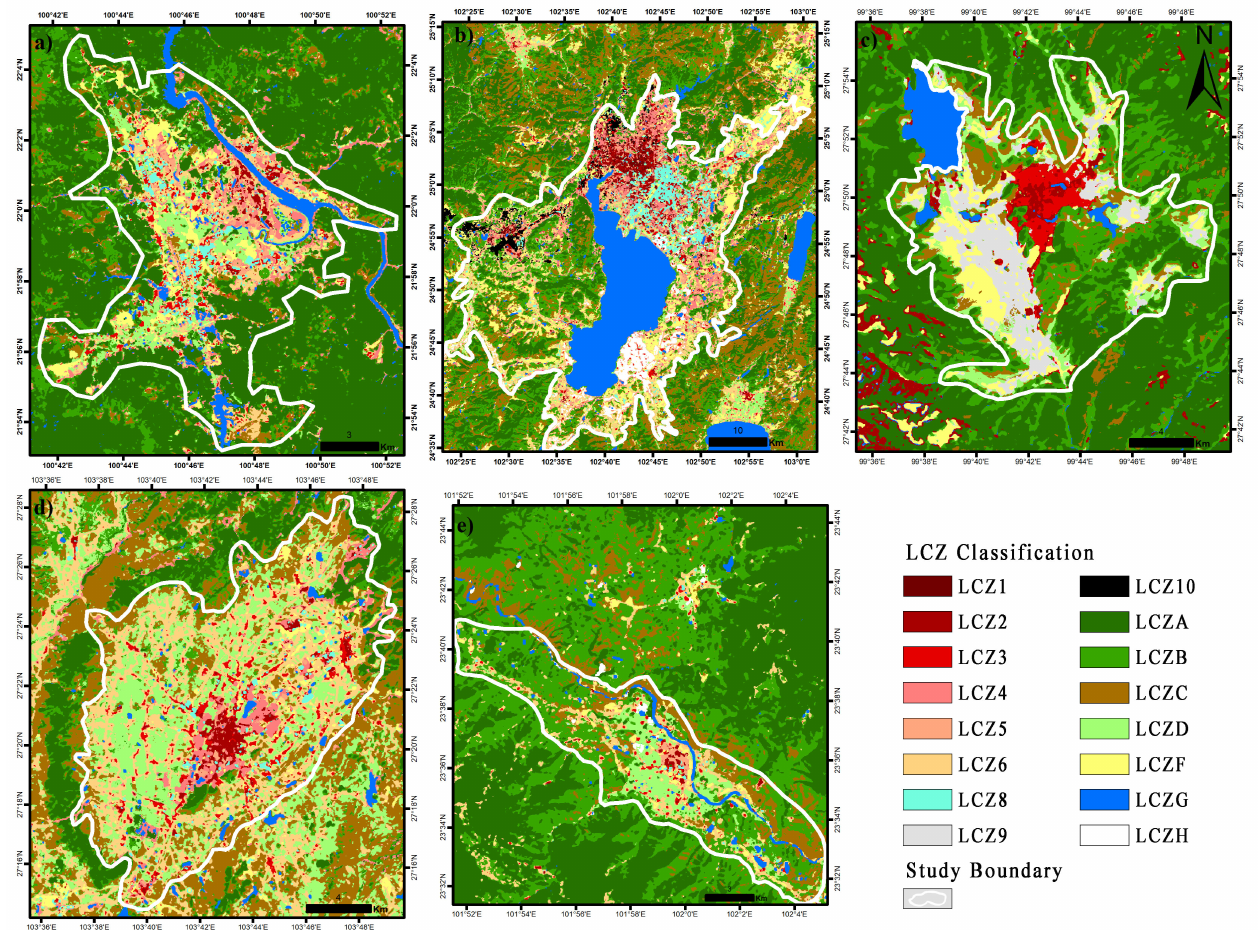
Figure 3. LCZ classification of the five cities in Yunnan Province ( a ) Jinghong, ( b ) Kunming, ( c ) Zhao- tong, ( d ) Shangri-La, ( e ) Yuanjiang).